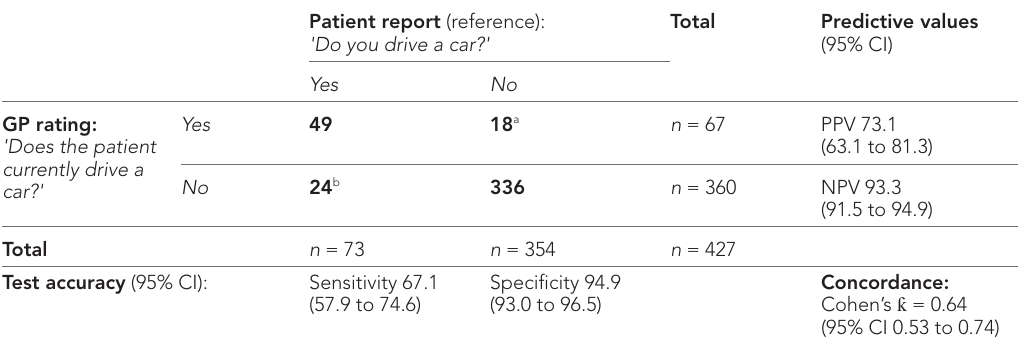
Table 1 Validity of the GP rating of driving activity